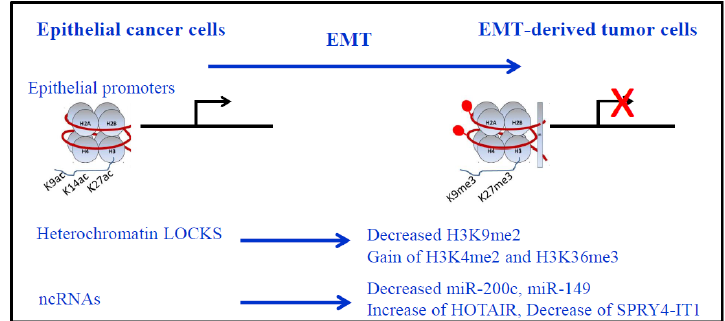
Figure 2. Epigenetic modifications during EMT. Nucleosomes are represented with DNA in red, wrapped around the histone core (2 copies of each histone H2A, H2B, H3 and H4) with the presence of histone H1 in more compact chromatin. Repression of epithelial genes (red cross) is shown with corresponding epigenetic modifications on their promoters: more compact chromatin, decreased H3K9/14/27ac and gain of H3K9me3 and H3K27me3, associated to DNA methylation (red lollipop). Of note, only major modifications for histone H3 are presented. LOCKS (long-range chromatin domains) epigenetic marks during EMT: Global reduction in the heterochromatin mark H3K9me2, increase in the euchromatin mark H3K4me3, and increase in the transcriptional mark H3K36me3. Non-coding RNAs (ncRNAs) expressions are also modified during EMT for miRNAs (loss of miR-200c and miR-149) and lncRNAs (increased HOTAIR and decreased SPRYA-IT1 in lung cancer).